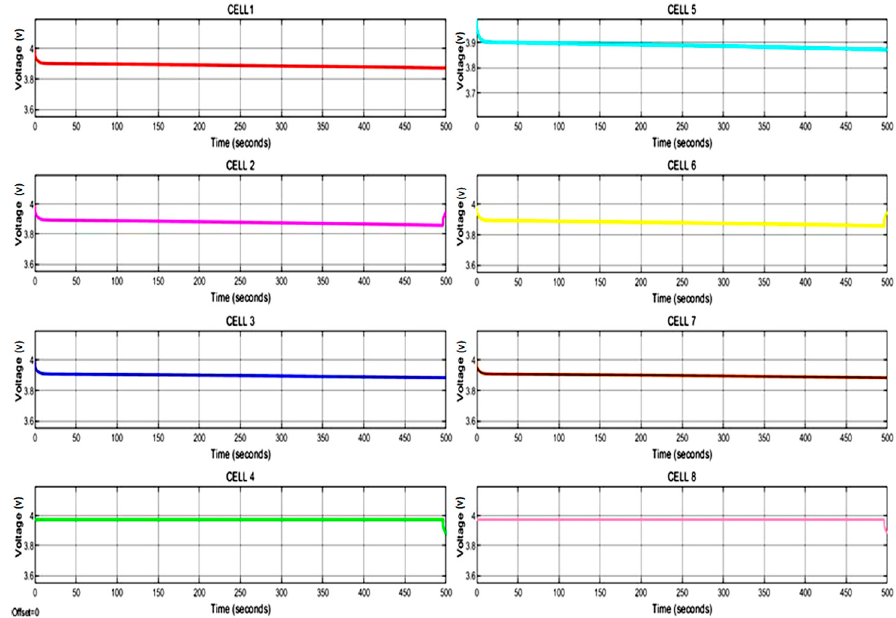
Figure 13. Active cell’s voltage waveforms—Voltage (volts) vs. Time (seconds) .